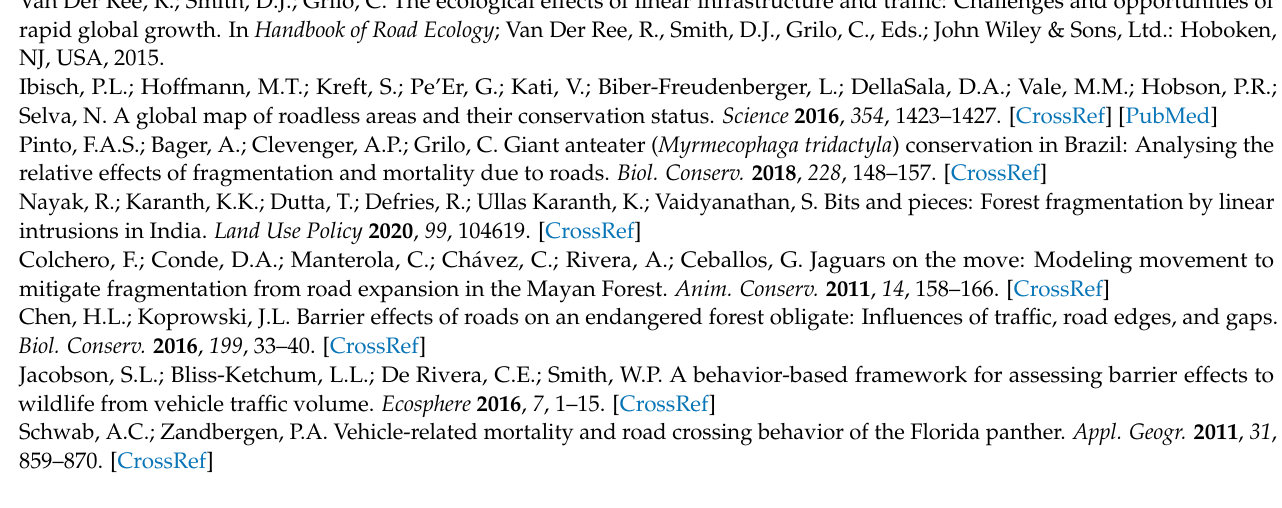
Table S2: Model selection table showing best models with factors explaining prey–predator, predator– prey and prey–dog latencies, with Akaike’s Information Criterion values, difference in AIC ( ∆ AIC) from the best model, and degrees of freedom (df). Models with AIC < 2 were averaged; Table S3: Model-averaged coefficients ( β ) for models explaining factors affecting prey–predator, predator– prey and prey–dog latencies at crossing structures on NH 44 passing through Pench Tiger Reserve, Maharashtra,